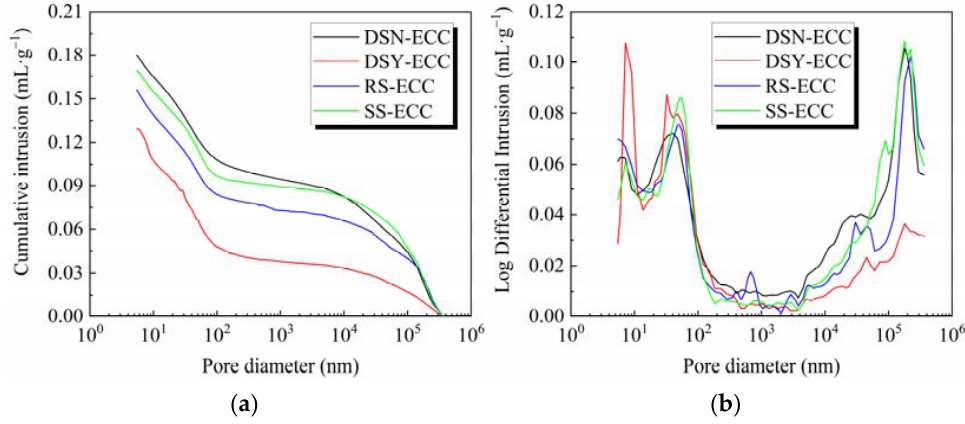
Figure 8. Pore structure parameters of different fine aggregates for ( a ) curve of cumulative mercury intake; ( b ) differential curve of pore diameter distribution. Table 6. Characteristic parameters of pore structure under different fine